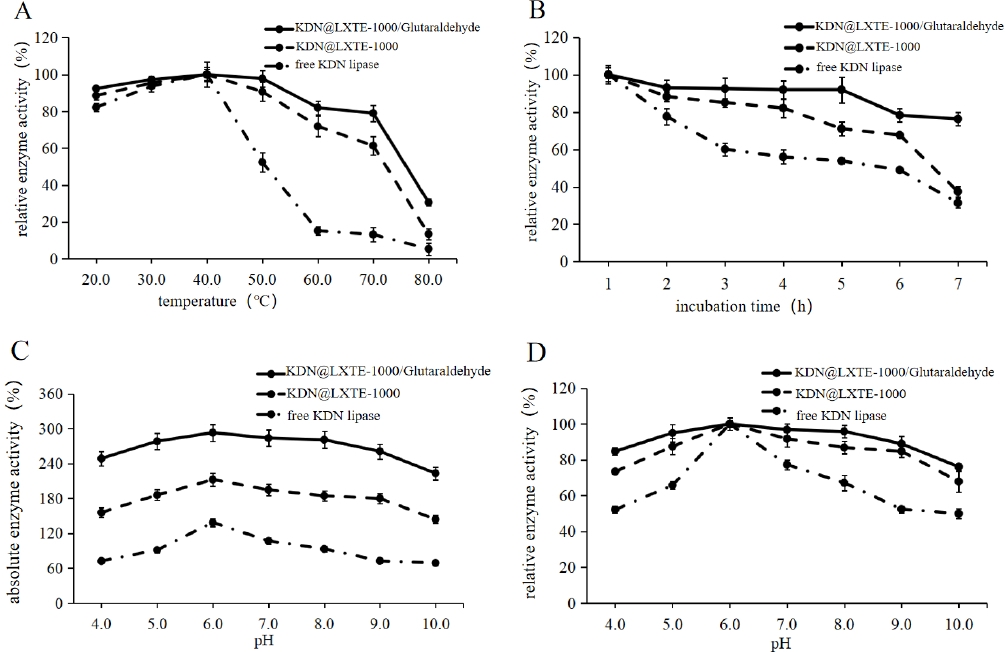
Figure 4. Thermal and pH stability of KDN@LXTE-1000/Glutaraldehyde, KDN@LXTE-1000, and free enzyme. ( A ) Determination of optimum temperature. ( B ) Determination of temperature stability. ( C ) Determination of pH stability (expressed with absolute enzyme activity). ( D ) Determination of pH stability (expressed with relative enzyme activity). The error bars show standard deviations; all studies were conducted in triplicate.